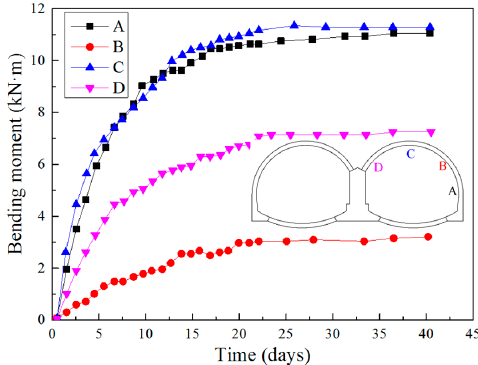
Figure 19. Time history plots of the bending moments in steel arches in the K89+729 section.